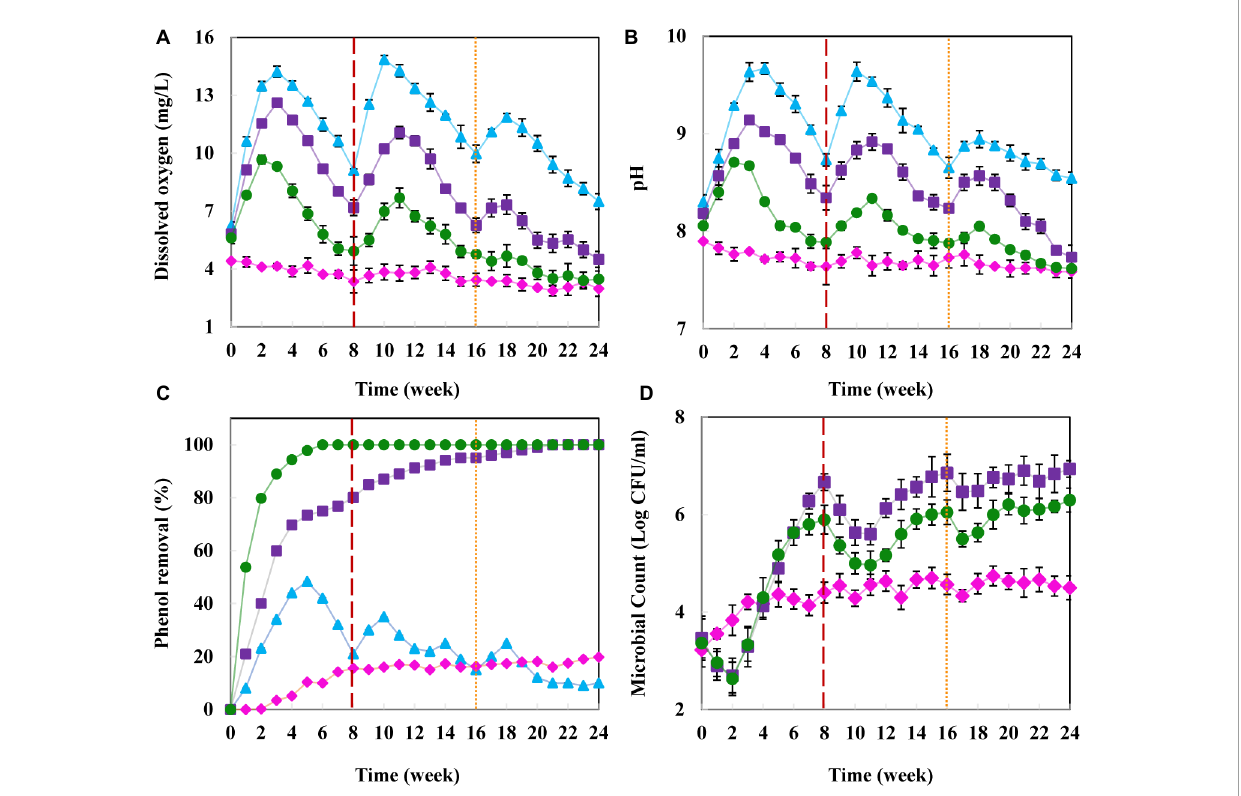
FIGURE2 Remediation of phenol from groundwater in the column experiments. (A) Dissolved oxygen concentration (mg/L), (B) pH, (C) phenol removal (%), and (D) intrinsic microbial count (log CFU/mL). Abiotic column ( (cid:78) ), natural remediation column II ( (cid:7) ), biostimulation column III ( (cid:4) ), and simultaneous biostimulation and bioaugmentation column IV ( • ). The red and orange dashed lines, respectively indicate 15 and 5 g CaO 2 nanoparticles re-injection to provide the proper contaminant removal condition.